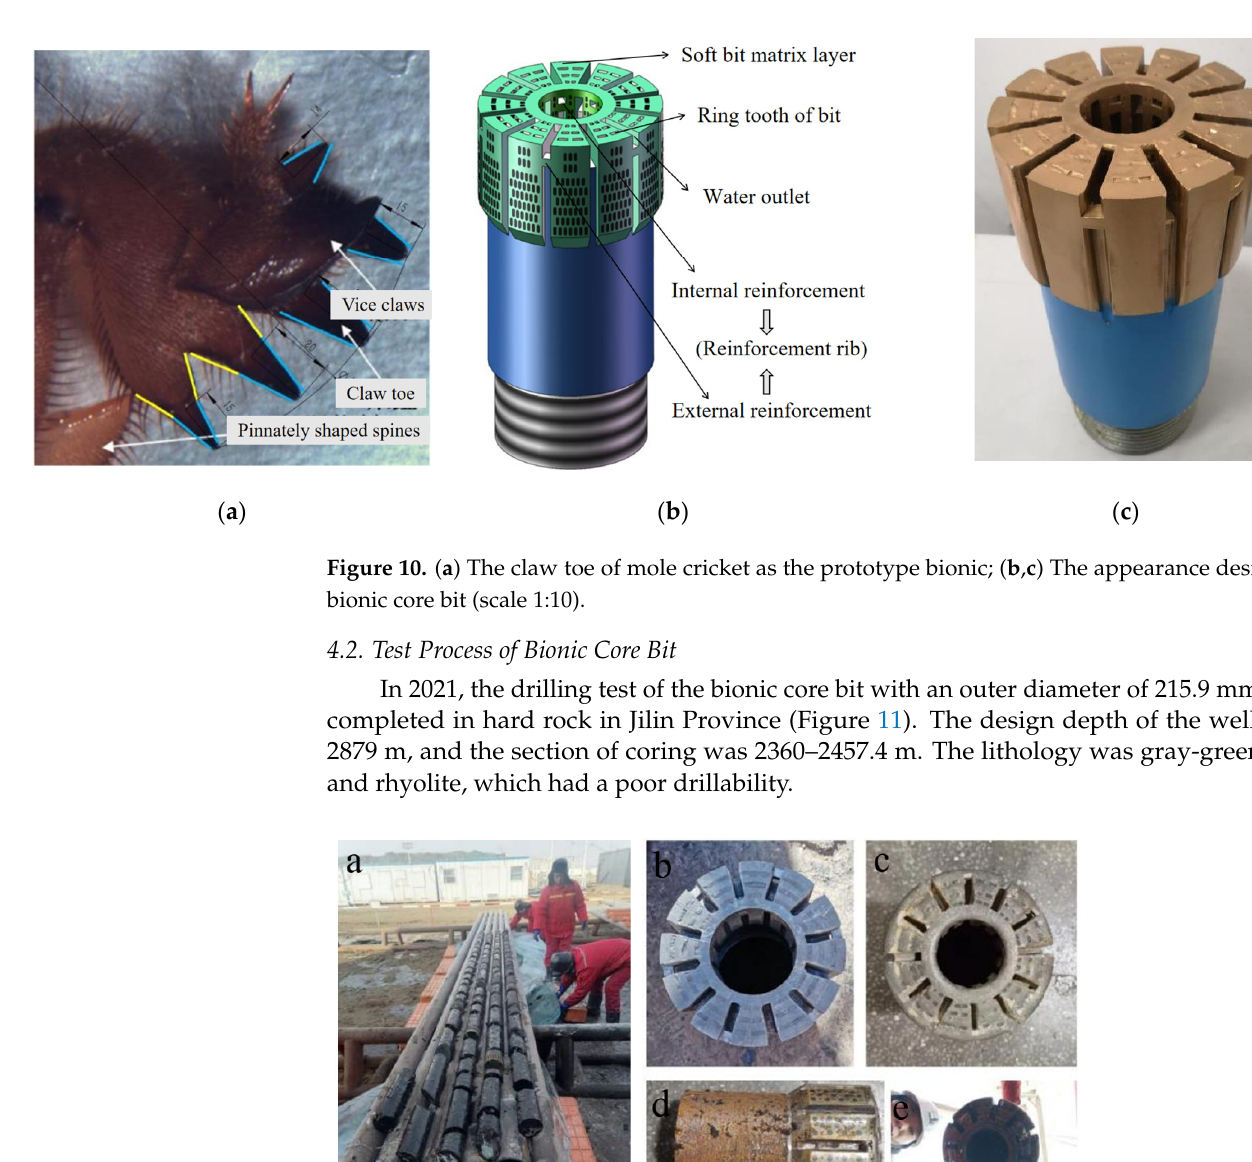
Figure 12. Relationship between WOB and ROP. After the test, the inner diameter of the working layer was worn by 5 mm, and the outer diameter was worn by 15 mm. The solution is to increase the effective cutting area of the outer diameter part; that is, to strengthen the reinforcement ribs at the water outlet without affecting the normal circulation of mud. Table 5. Statistics on bit drilling efficiency of bionic core bit. Number